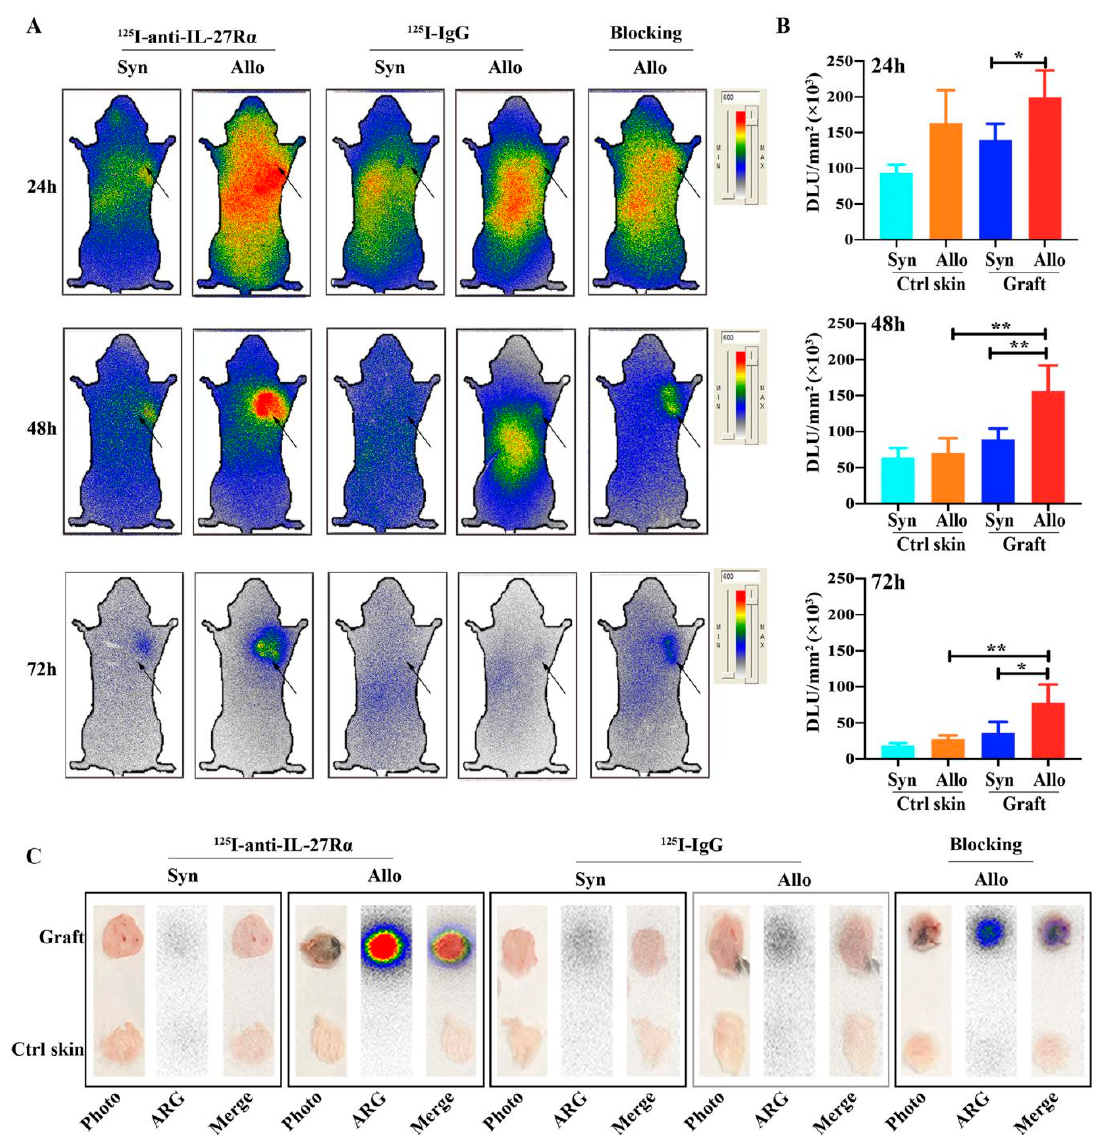
Figure 3. Dynamic whole-body phosphor-autoradiography imaging of the mouse model on day 10 post transplantation. The 125 I-anti-IL-27R α mAb was injected into the model mouse at day 8 post transplantation and imaged at 24 h (day 9), 48 h (day 10) and 72 h (day 11). The blocking group was preinjected with excessive unlabeled anti-IL-27R α mAb. ( A ). Whole-body phosphor-autoradiography of syngeneic and allogeneic grafted groups. ( B ). Semi-quantitative assay of radioactivity accumulation of 125 I-anti-IL-27R α mAb represented as DLU/mm 2 . ( C ). Ex vivo phosphor-autoradiography (ARG) imaging of the graft and opposite control skin (* p < 0.05, ** p < 0.01 vs. control group). The semi-quantitative assay (DLU/mm 2 ) of the phosphor-autoradiography image in Figure 3B showed higher radioactivity in the allogeneic graft (199,687 ± 37,079 vs. syngeneic graft, 139,519 ± 22,836, p < 0.05) at 24 h post injection. The prominently higher radioactivity accumulation in the